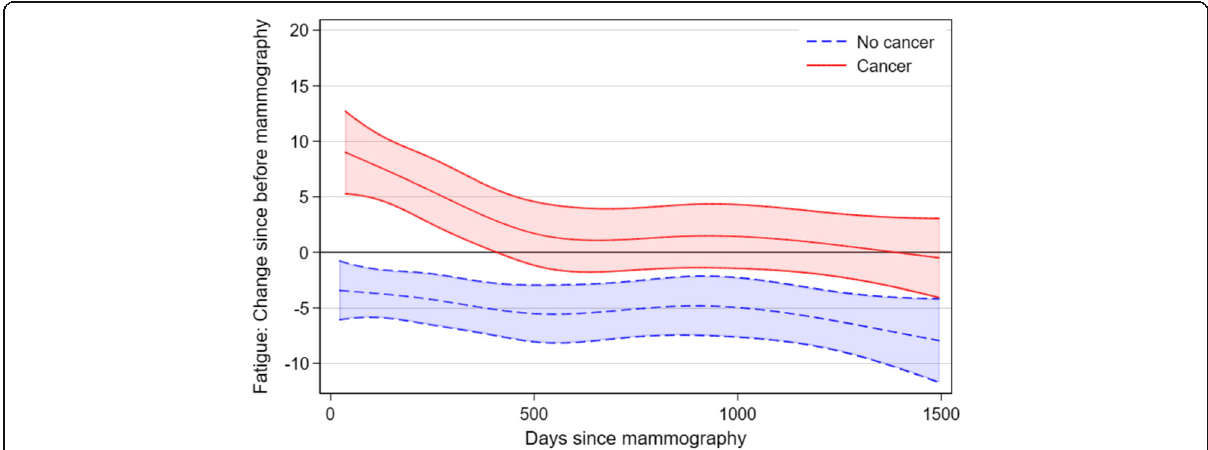
Fig. 3 Mean change in fatigue from before mammography among women with and without breast cancer